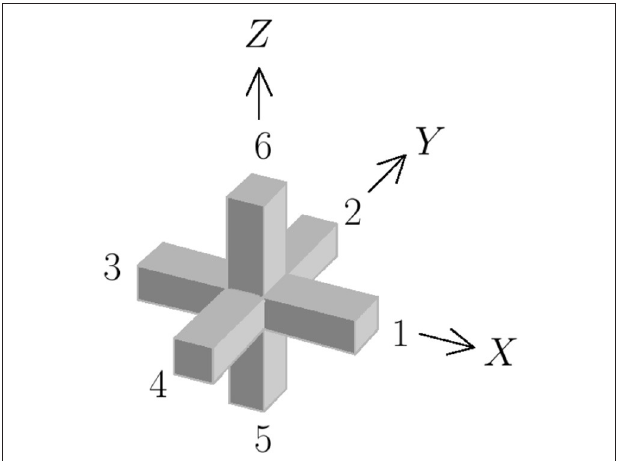
FIGURE 1 | Enumeration scheme for the discrete “beam” elements of a cube lattice connecting node i to its nearest neighbors j = 1 to j = 6, showing the coordinate system with node i as its origin. Although cross-sections have been shown as square we do not intend to imply any specific geometry for the discrete